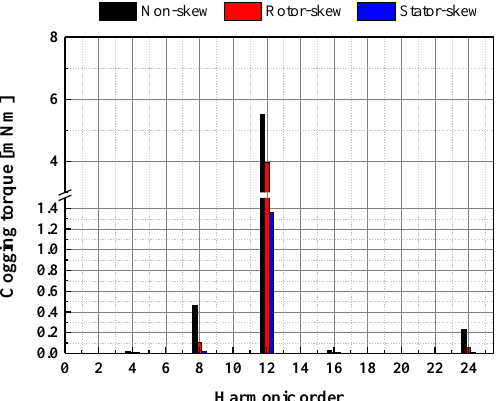
Figure 13. Harmonic order results with the measured B r and skew angle.